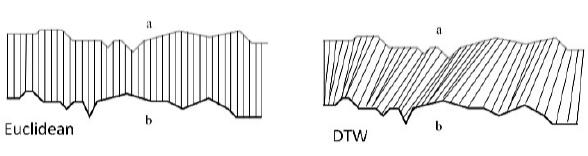
Figure2. Sketch of Euclidean and DTW.